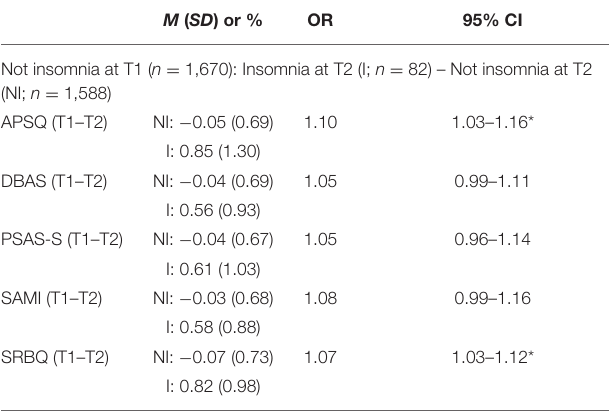
TABLE 5 | Changes in cognitive processes over time between those with and without incident insomnia at the subsequent assessment: descriptive statistics and multivariate logistic regression analyses.